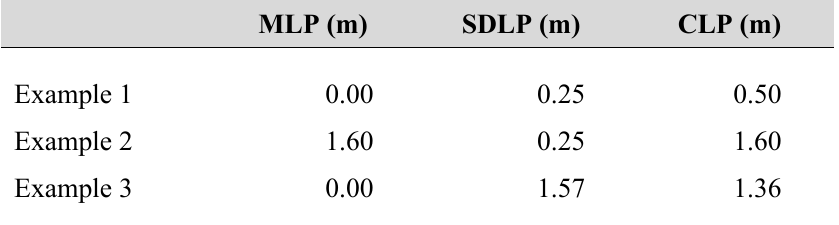
Table 1 Mean Lateral Position (MLP), SD Lateral Position (SDLP), and the new index Cumulative Lateral Position (CLP) for the three examples